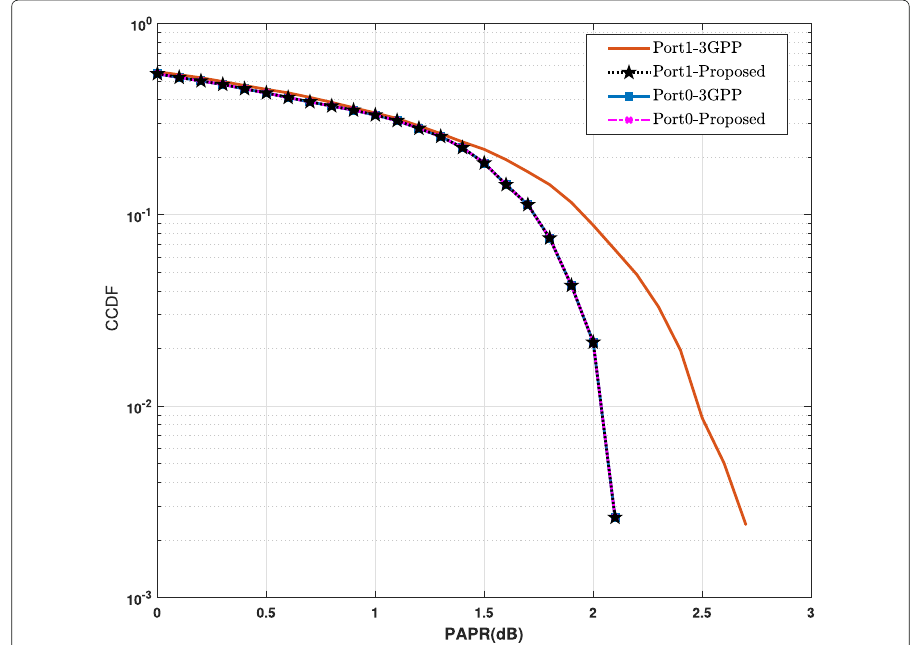
Fig. 21 PAPR comparison of length-6 DMRS sequences on port 0 and port 1 with proposed and 3GPP transmitter